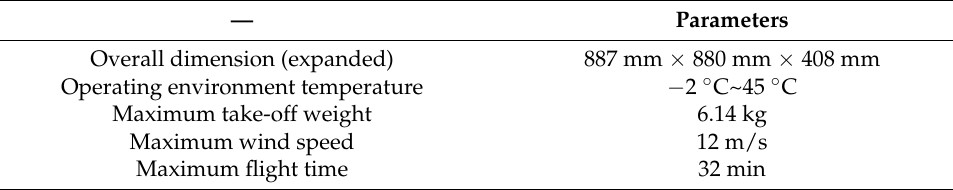
Table 1. Basic parameters of DJI Jingwei’s Matrice 210 RTK UAV.